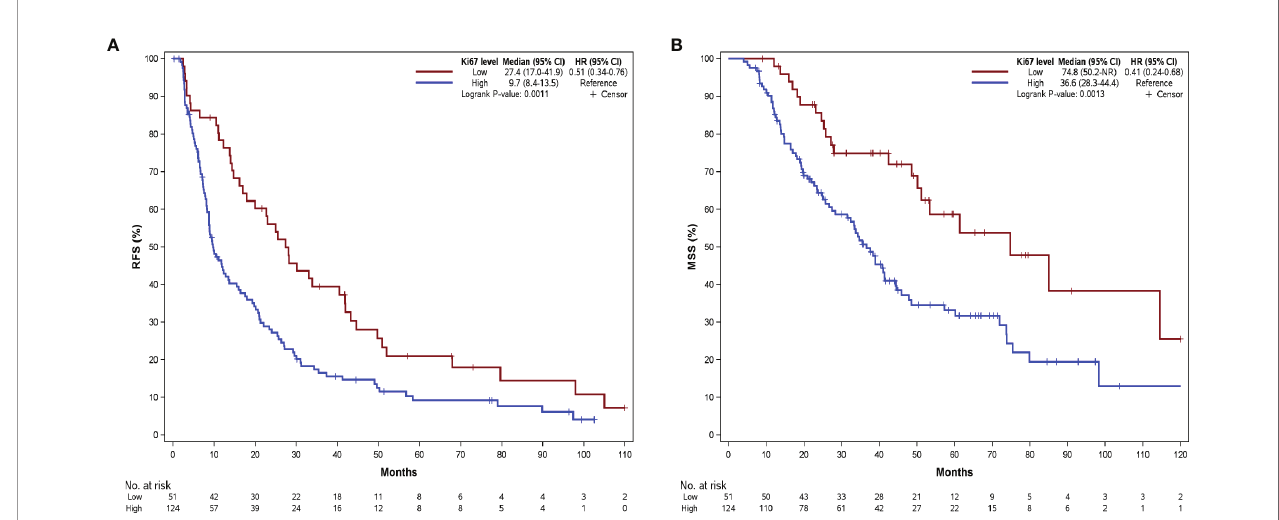
FIGURE 3 | Kaplan-Meier curves of RFS (A) and MSS (B) according to patients at different Ki67 levels. RFS, relapse-free survival; MSS, melanoma-speci fi c survival.